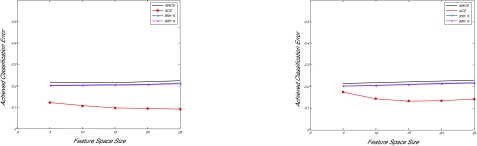
PACE analysis using a SVM-based classifier using the simple separability scoring criterion, with a 0.6 MAC threshold. Left Panel: performance without peak selection. Right panel: performance with peak selection.